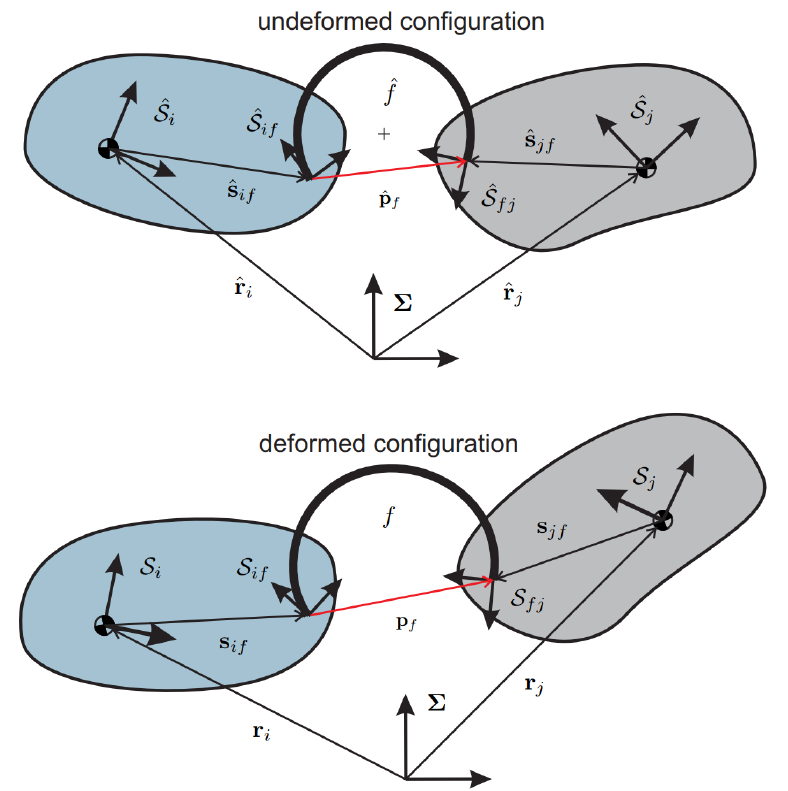
Figure 2. Deformation of a curved beam due to the relative motions of the bodies connected to its